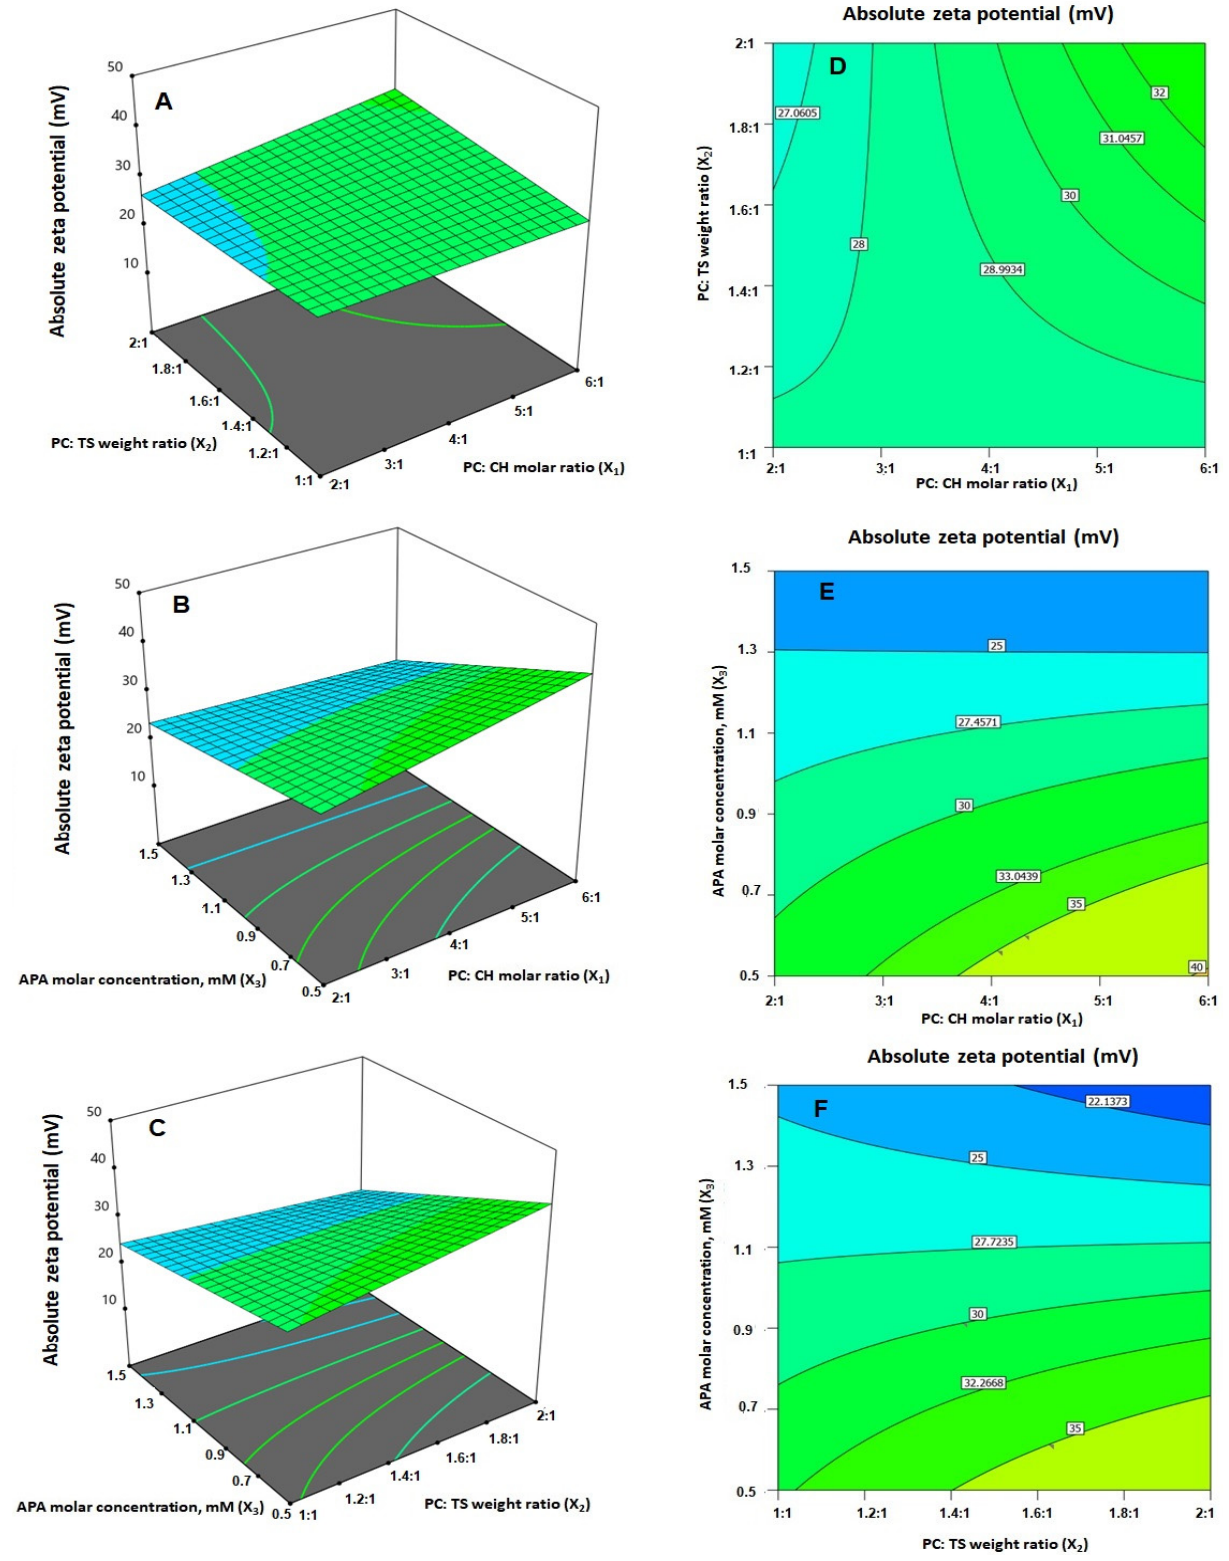
Figure 5. ( A – C ) Response surface 3D- and ( D – F ) contour 2D-plots showing the interaction between the investigated variables on the absolute zeta potential value of EGA-EML-APA. Abbreviations: EGA, ellagic acid; EML, emulsomes; APA, apamin; PC: Phospholipon 90 G; Cholesterol: CH; TS; Tristearin.